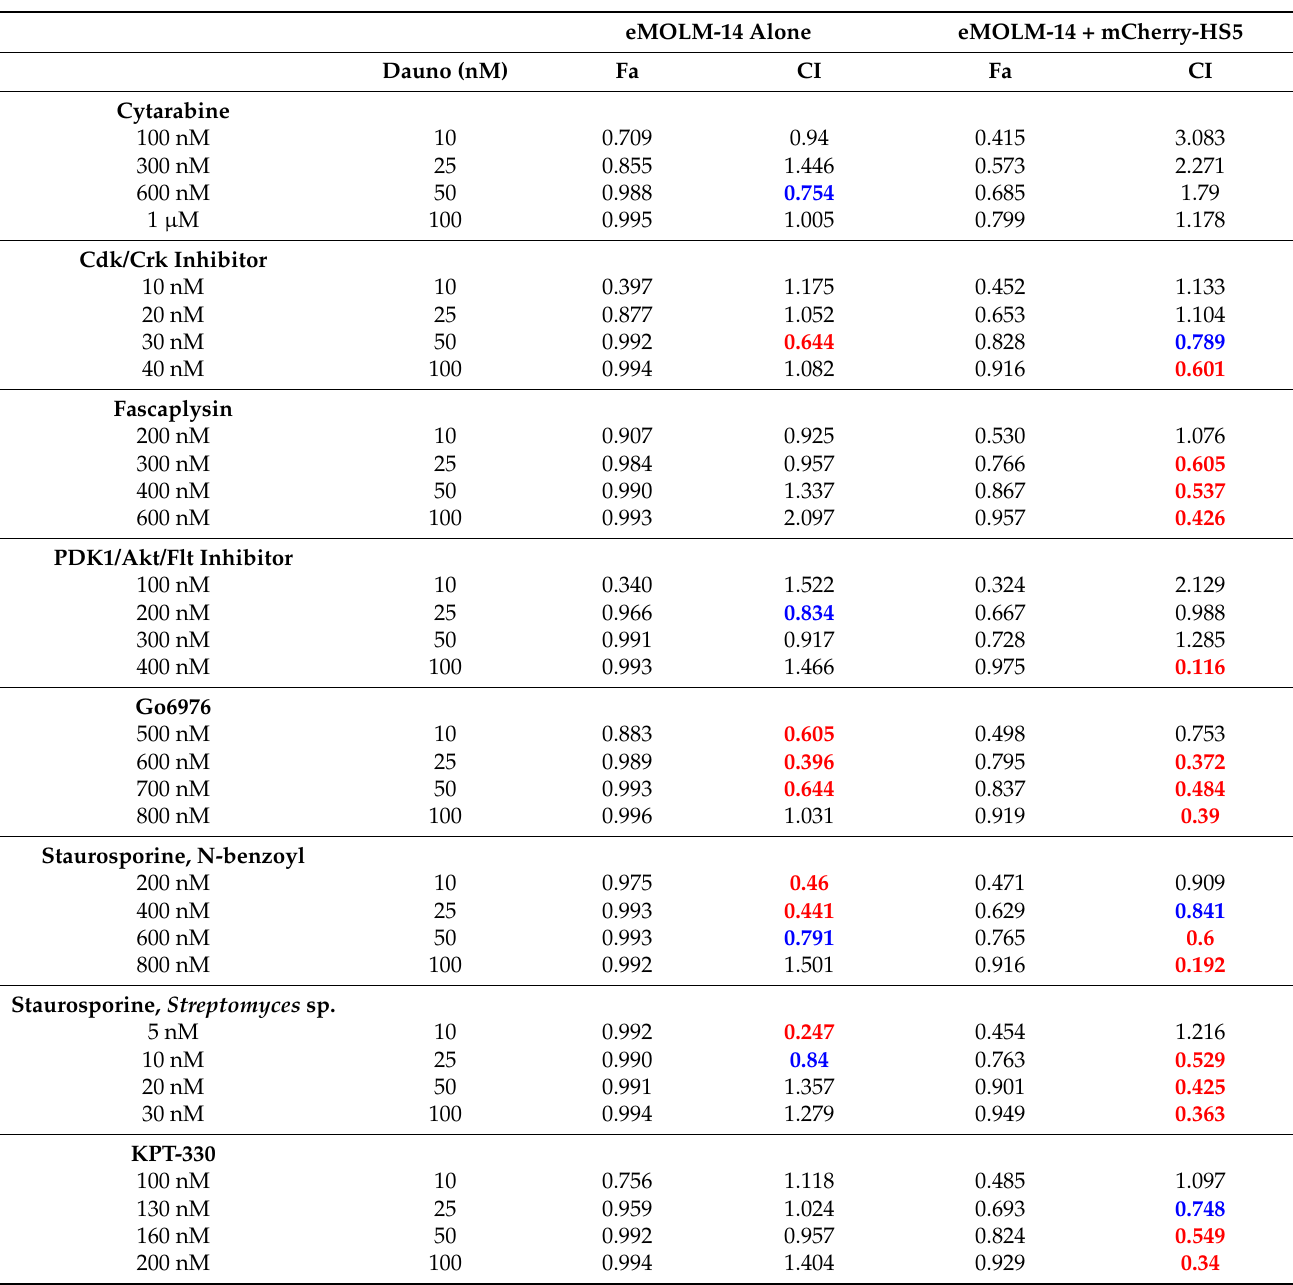
Table 2. Analysis of the possible synergistic effect of selected hit compounds. Combination index (CI) and affected fraction (Fa) of the listed compounds are shown at the specified concentration in combination with 10, 25, 50 and 100 nM daunorubicin in eGFP–MOLM-14 cells cultured alone or in co- culture with mCherry-HS5 cells. CI values labelled in red indicate synergism or very strong synergism, according to the Chou–Talalay method. CI values labelled in blue indicate moderate synergism. eMOLM-14